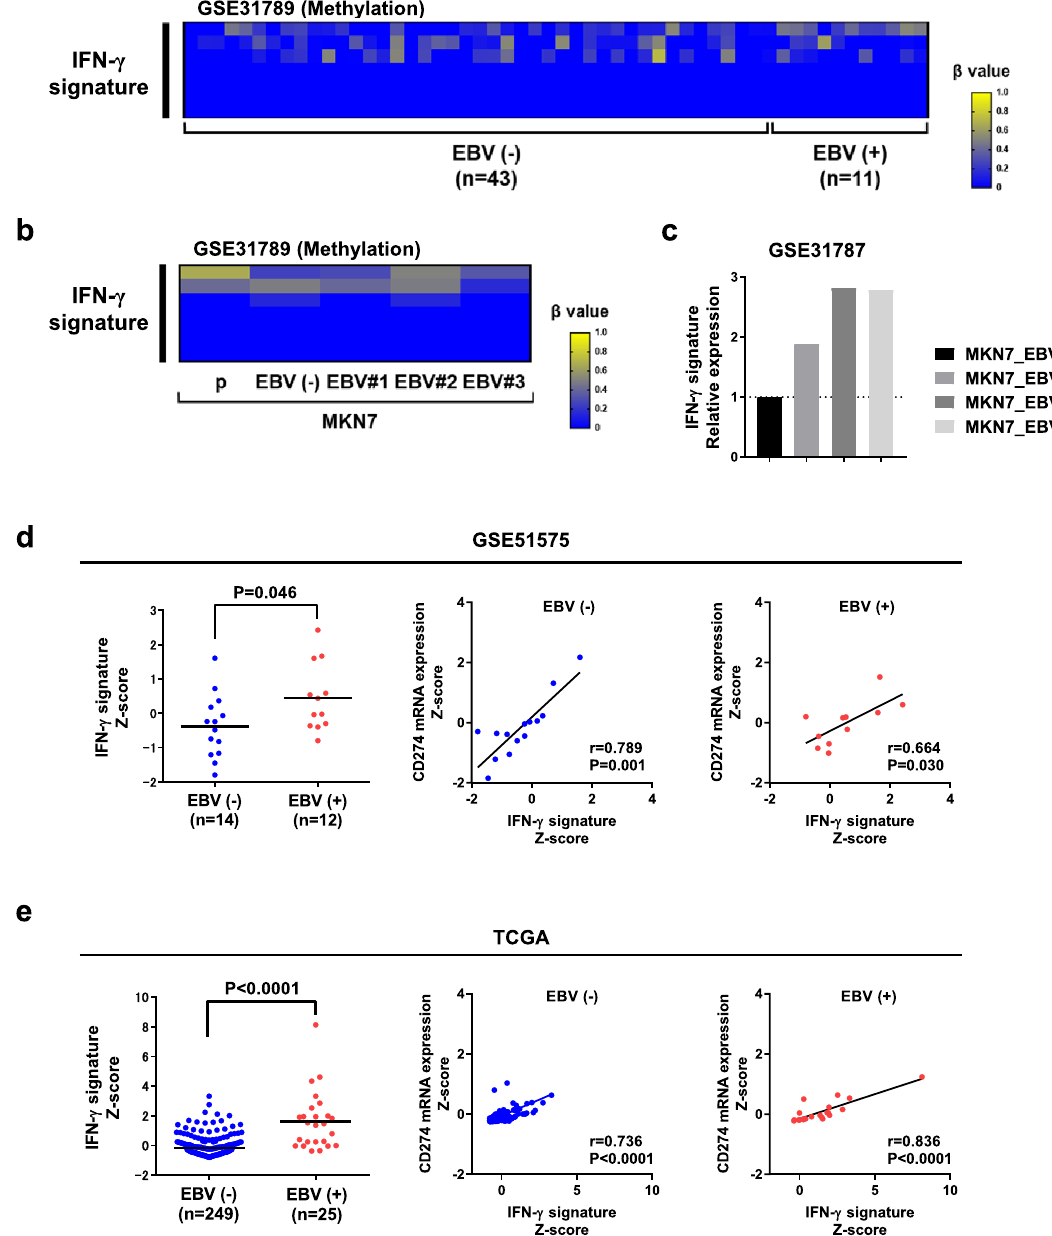
Figure 2. DNA methylation status of IFN-γ signature genes and correlation between IFN-γ signature gene expression and CD274 mRNA expression in EBV (+) GC. (a) DNA methylation status of IFN-γ signature genes (six genes) in EBV (−) (n = 43) and EBV (+) (n = 11) GC (GSE31789). DNA hypermethylation was not observed in IFN-γ signature genes. The β value (0.00 to 1.00) reflects the methylation level at individual CpG sites. (b) DNA methylation status of IFN-γ signature genes (six genes) among parent (MKN7 p), mock [MKN7 EBV (−)], and EBV-infected clones (MKN7 EBV#1, EBV#2, and EBV#3) of MKN7 cells (GSE31789). DNA hypermethylation of IFN-γ signature genes was not observed. The β value (0.00 to 1.00) reflects the methylation level at individual CpG sites. (c) Comparison of IFN-γ signature gene expression between mock and EBV- infected MKN7 cell clones (GSE31787). The IFN-γ signature was upregulated in EBV-infected MKN7 cells compared with control cells. (d) Differential expression of IFN-γ signature genes between EBV (−) and EBV (+) GC (left, GSE51575). IFN-γ signature genes were upregulated in EBV (+) GC compared with EBV (−) GC (P = 0.046). Comparison of IFN-γ signature and CD274 mRNA expression in EBV (+) and EBV (−) GC (right two panels). Expression of CD274 mRNA correlated positively with IFN-γ signature expression in EBV (+) GC (P = 0.030). (e) Differential expression of IFN-γ signature genes between EBV (−) and EBV (+) GC (left, TCGA). IFN-γ signature genes were upregulated in EBV (+) GC compared with EBV (−) GC (P < 0.0001). Comparison of IFN-γ signature and CD274 mRNA expression in EBV (+) and EBV (−) GC (right two panels). Expression of CD274 mRNA correlated positively with IFN-γ signature expression in EBV (+) GC (P <